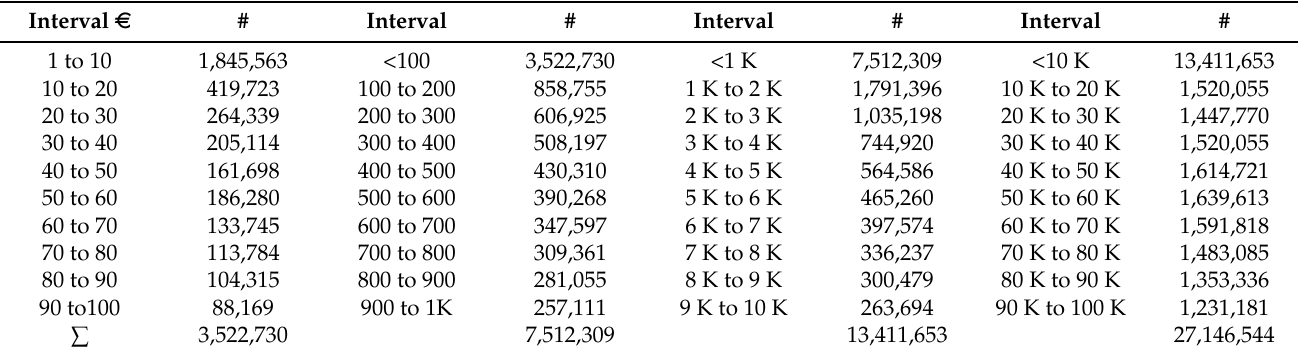
Table 3. Frequency of assets in the range 1–100,000 e